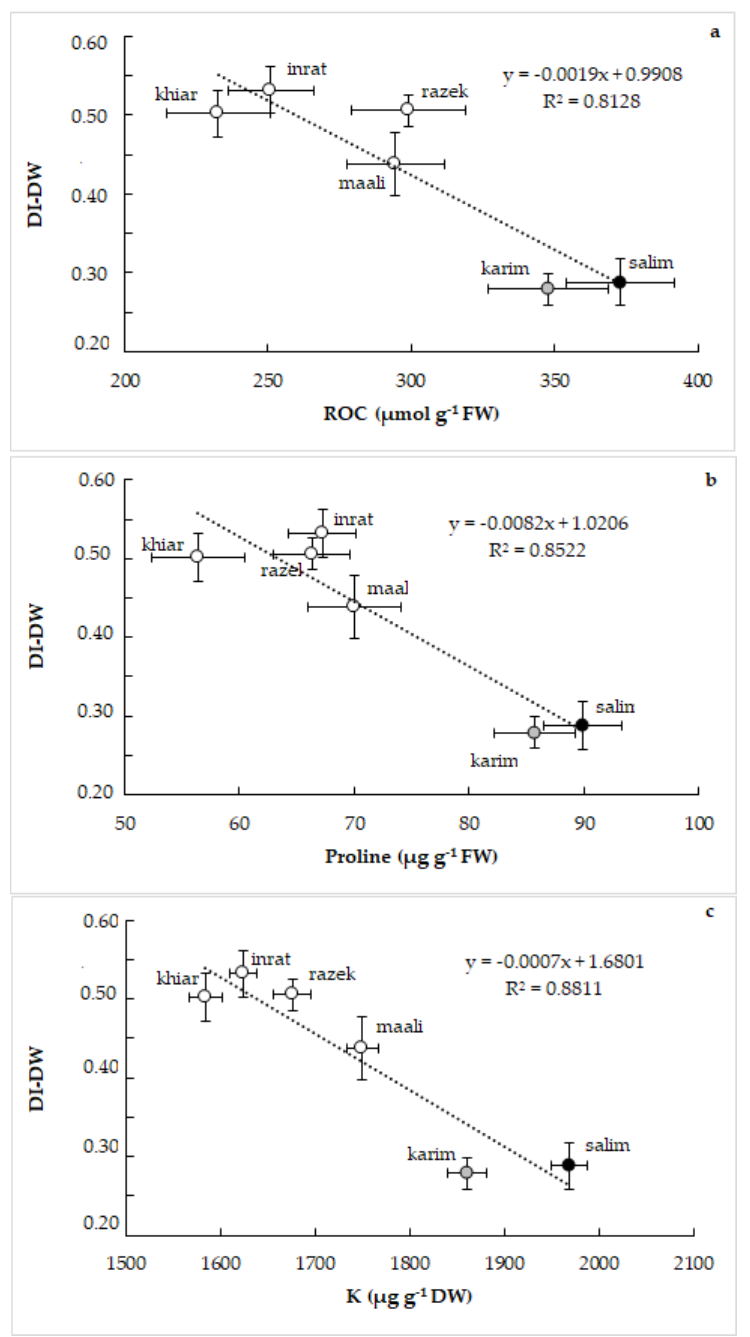
Figure 6. Relationships between drought index based on dry weight (DI-DW) and relative osmolyte content (ROC, ( a )), between drought index based on dry weight (DI-DW) and proline concentra- tion ( b ), and between drought index based on dry weight (DI-DW) and potassium (K) concentration ( c ) in shoots of durum wheat ( Triticum durum Desf.) subjected to drought stress. Vertical standard errors of means of 30 replicates; horizontal standard errors of means of 10 replicates.